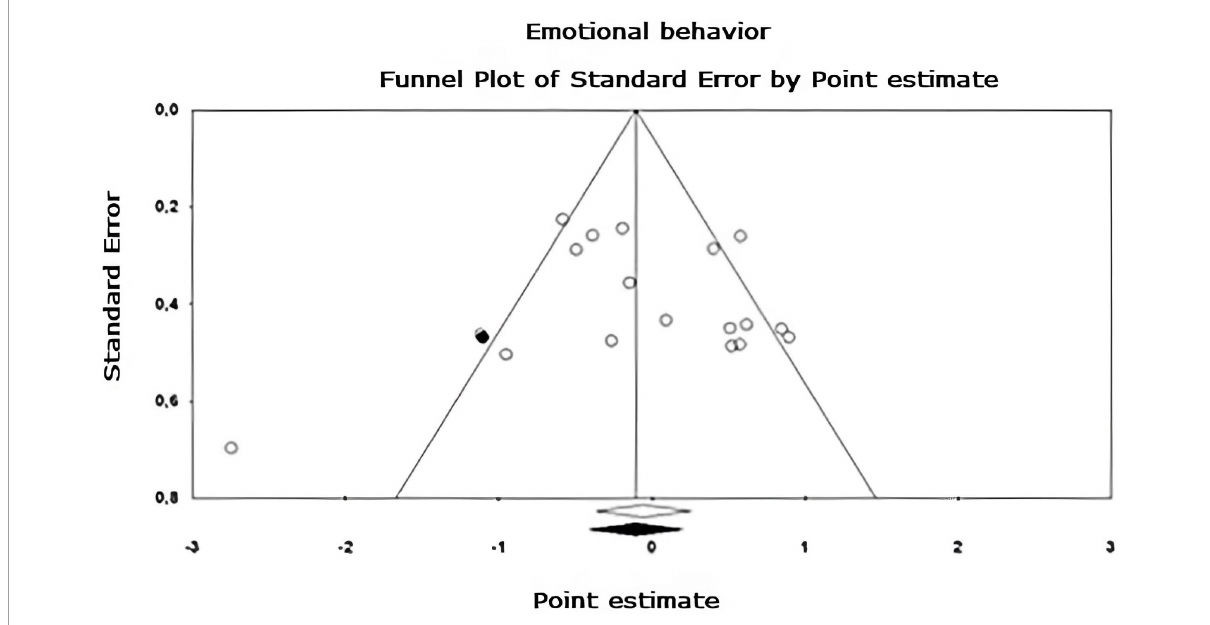
FIGURE8 Funnel plot of publication bias for the emotional behavior sub-metaanalysis, created using the Trim and Fill method (Duval and Tweedie, 2000). It shows an estimate of the effect sizes of all UAs. Data obtained from the experiments are shown in white and the imputed data point is shown in black.